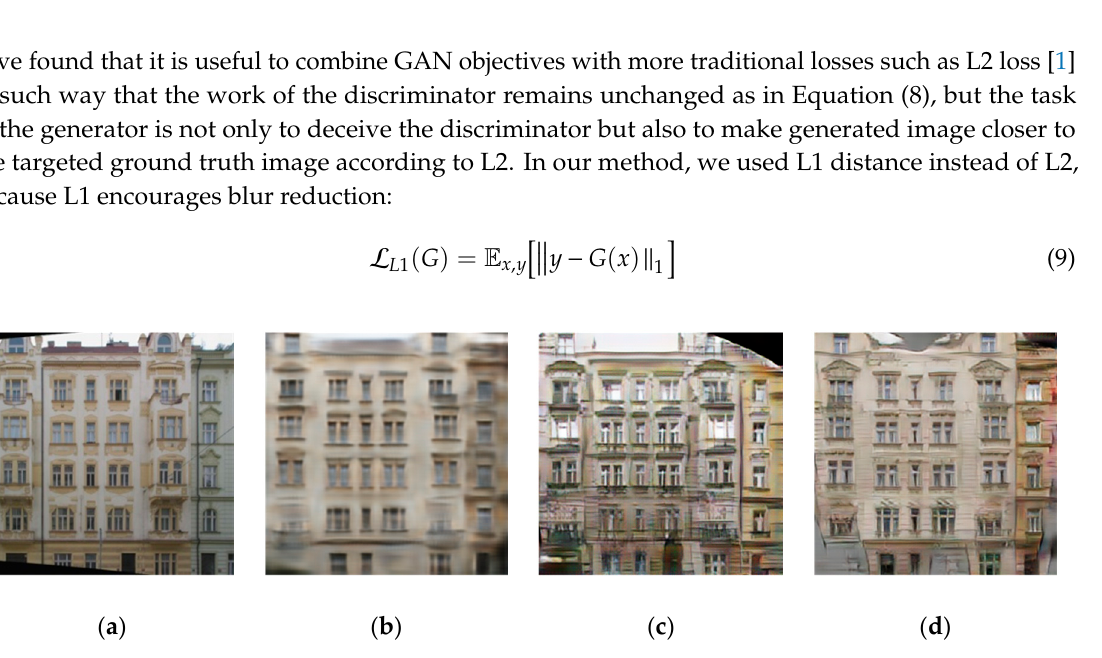
Table 2. Generator Network of IP-RAN.